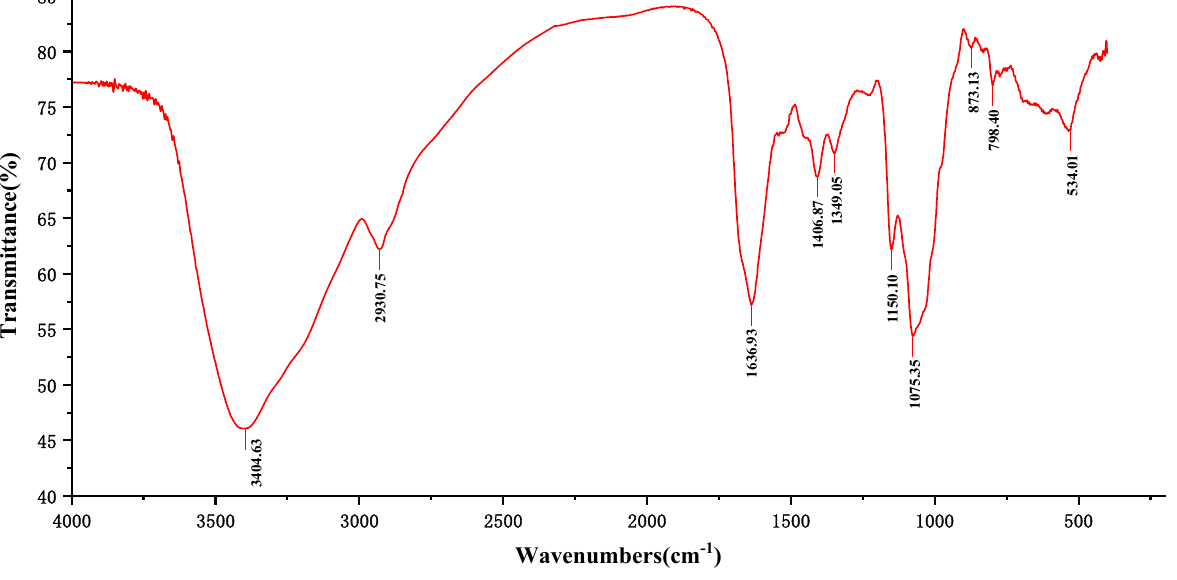
Figure 2. FT-IR spectrum of Pseudostellaria heterophylla polysaccharides.